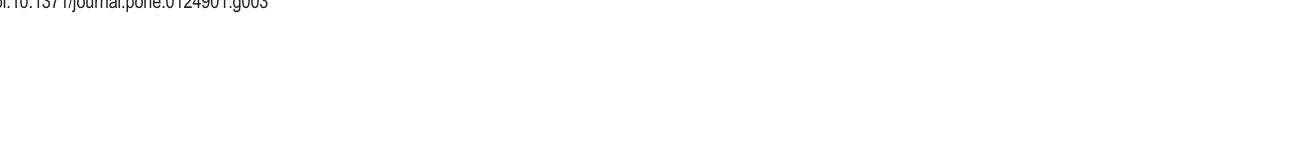
PLOS ONE | DOI:10.1371/journal.pone.0124901 April 8,